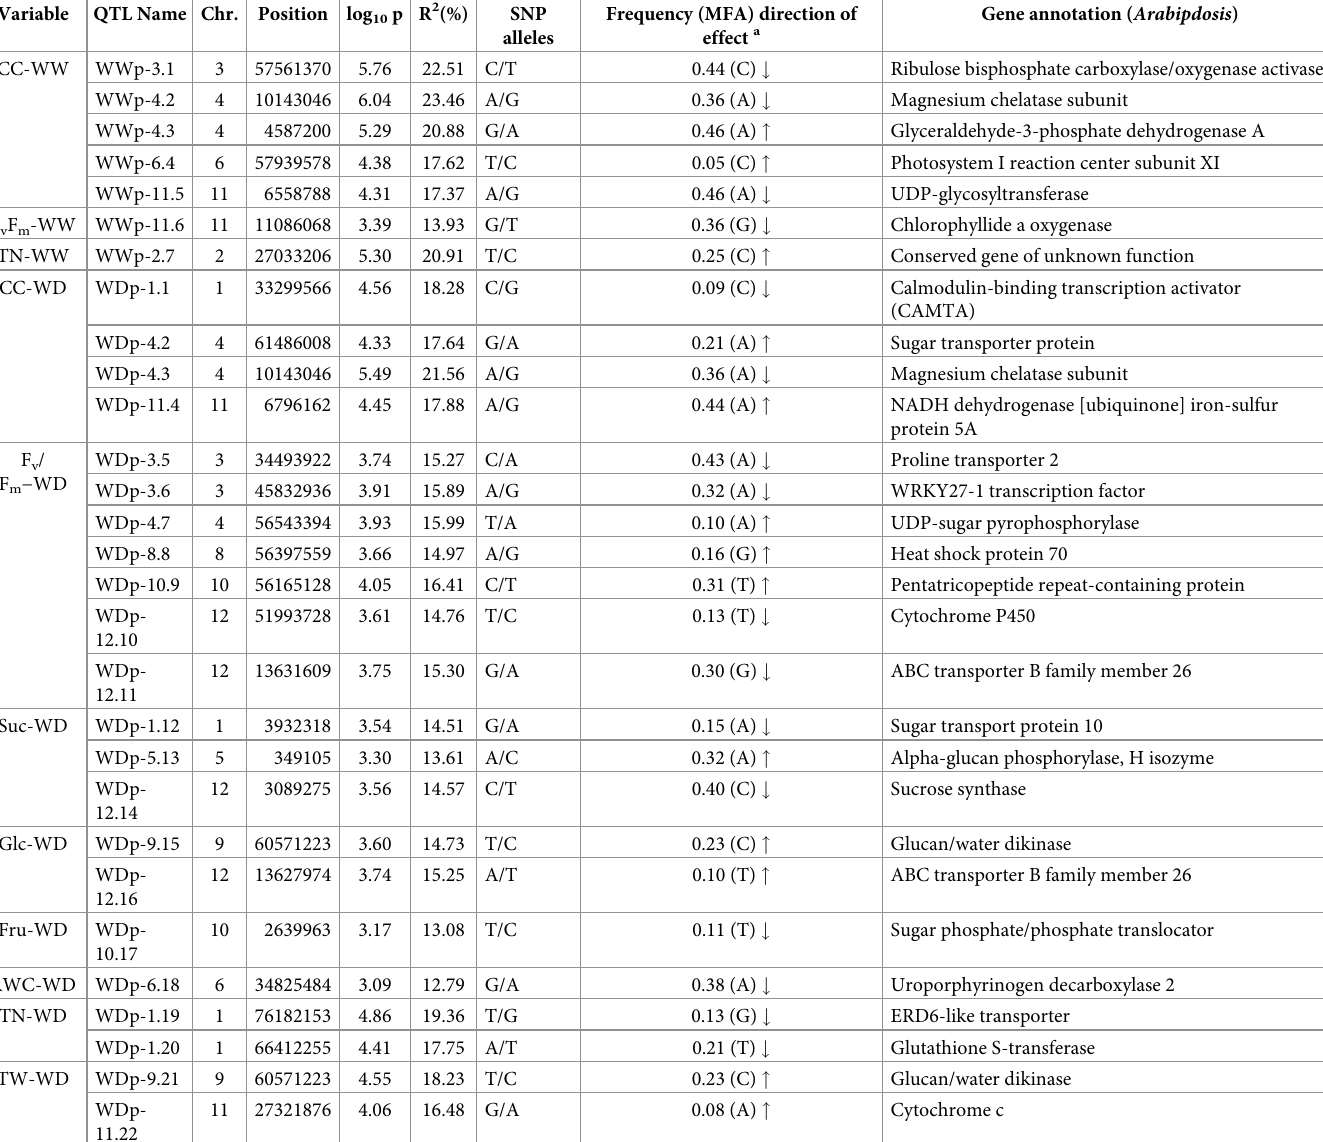
Table 1. Summary of genome associations for well-watered and water deficit conditions. Variable, QTL name, chromosome (Chr), position, its significance, pheno- typic variance explains by QTL (R 2 (%)), SNP alleles, frequency (MFA) and direction of effect and gene annotation where the QTL resides. Relative chlorophyll content (CC), well-watered condition (WW), maximum quantum efficiency of PSII (F v F m ), tuber number (TN), water deficit condition (WD), sucrose (Suc), Glucose (Glc), fruc- tose (Fru), relative water content (RWC) and tuber fresh weight per plant (TW). Variable QTL Name Chr. Position log 10 p R 2 (%)